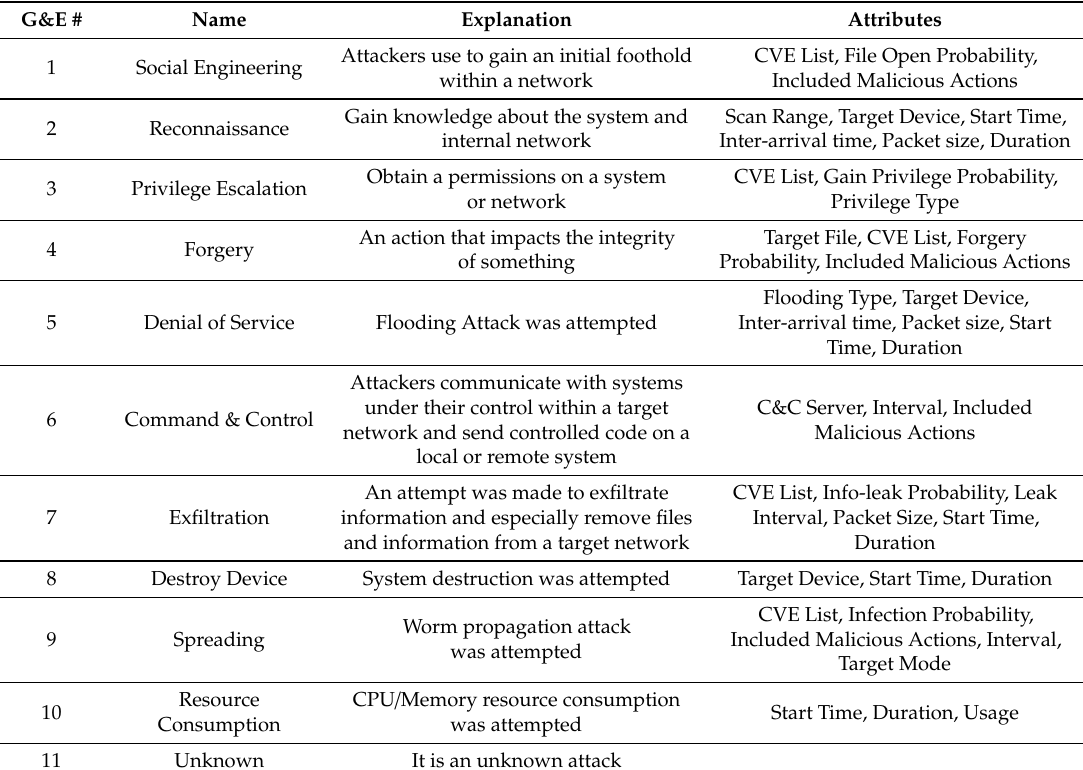
Table 1. Explanation and attributes of G&E